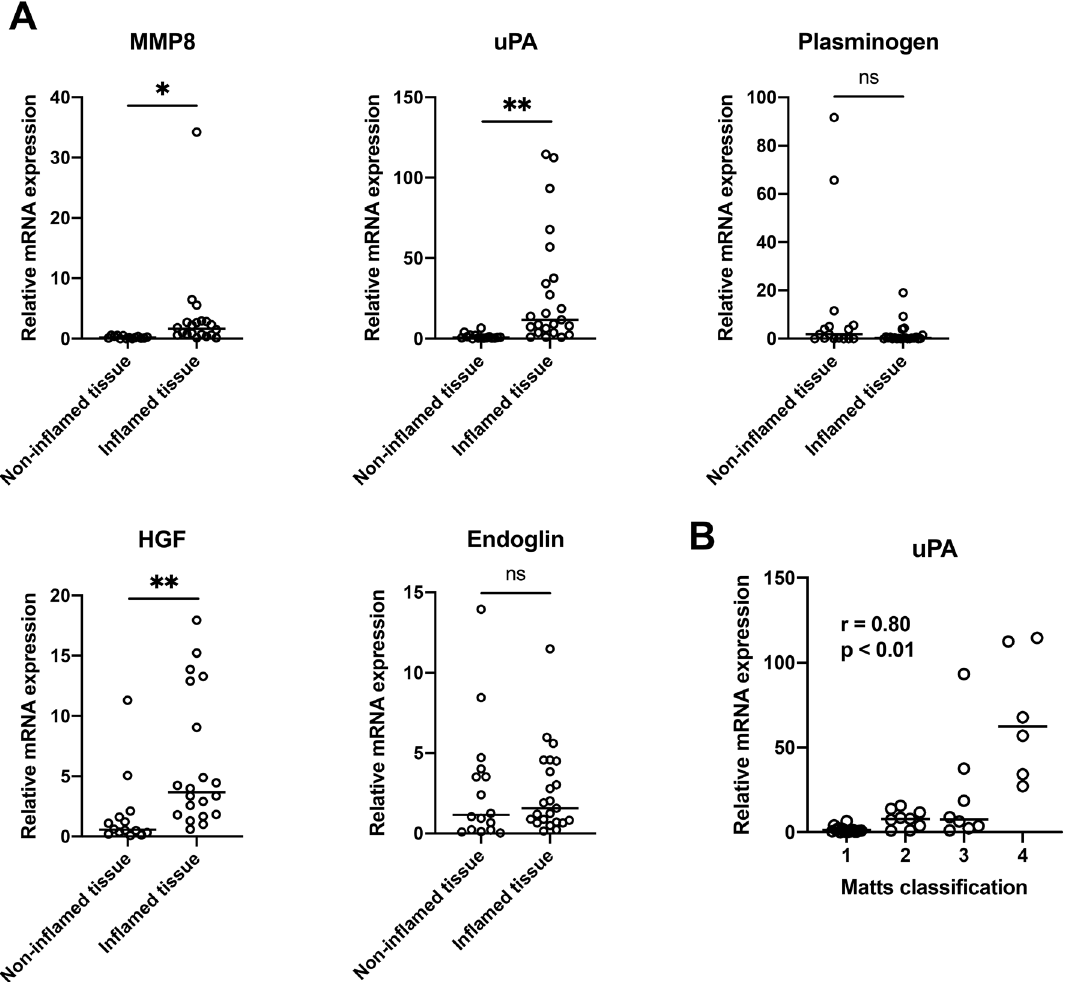
Figure 1. Expression of angiogenesis-related factors in inflamed or non-inflamed colorectal tissue of UC patients. ( A ) Levels of mRNA of five angiogenesis-related factors (MMP8, uPA, PLG, HGF, ENG) in the inflamed (n = 21) or non-inflamed (n = 15) colorectal tissue of UC patients were quantified by real-time PCR. Each bar represents the median value. * p < 0.05, ** p < 0.01 by MannWhitney U test. ( B ) Endoscopic severity of disease in the colorectum assessed using Matts classification. Correlations between uPA levels and Matts classification in 36 specimens (21 inflamed tissue and 15 non-inflamed tissue) were analyzed using Spearman’s rank correlation test, r = 0.80, p <